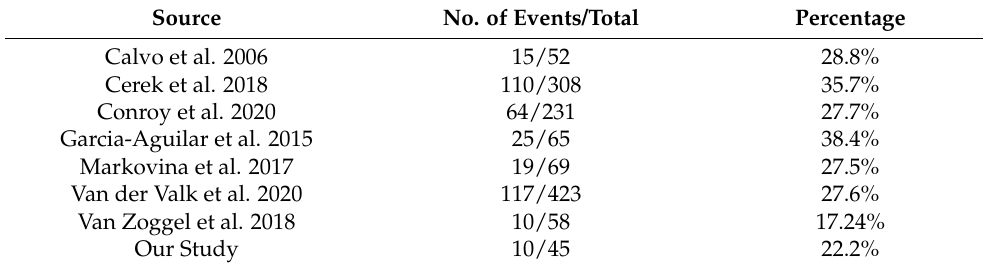
Table 2. Literature data supporting the TNT strategy [17].